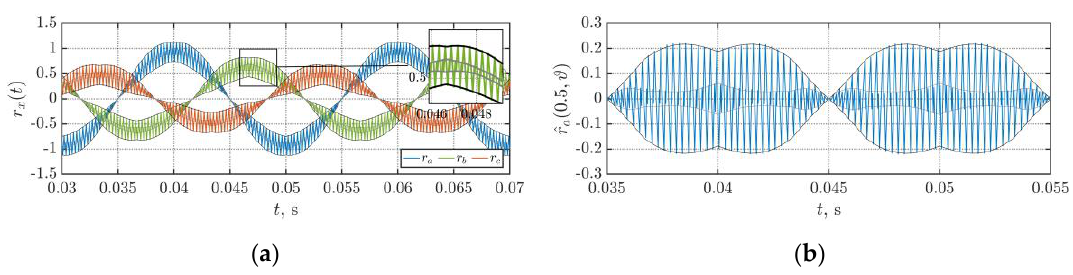
( a ) ( b ) Figure 8. Primary (black) and secondary (gray) envelopes in case of THIPWM1/6 at m = 0.5 and f sw = 3.6 kHz: ( a ) Normalized phase currents; ( b ) Normalized phase current ripple. ( a ) ( b ) Figure 9. Primary (black) and secondary (gray) envelopes in case of THIPWM1/4 at m = 0.5 and f sw = 3.6 kHz: ( a ) Normalized phase currents; ( b ) Normalized phase current ripple. As discussed before, DPWMMAX (Figure 10) and DPWMMIN (Figure 11) do not present a half- wave symmetry. However, as it has been shown in (17) for their modulating signals, also the current ripple could be interchangeably examined by DPWMMAX or DPWMMIN, but half-cycle displaced (+π). Both envelopes match with the simulation profiles. ( a ) ( b ) Figure 10. Primary (black) and secondary (gray) envelopes in case of DPWMMAX at m = 0.5 and f sw = 3.6 kHz: ( a ) Normalized phase currents; ( b ) Normalized phase current ripple.